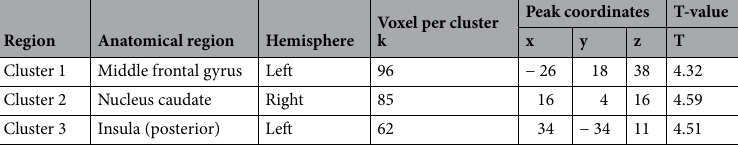
Table 3. Clusterwise statistics of the functional connectivity analysis with the FUN > TYP contrast. All reported regions were corrected for multiple comparisons on a cluster threshold of p < 0.05, voxel threshold p = 0.001, k = 47 voxel. Coordinates are reported in MNI